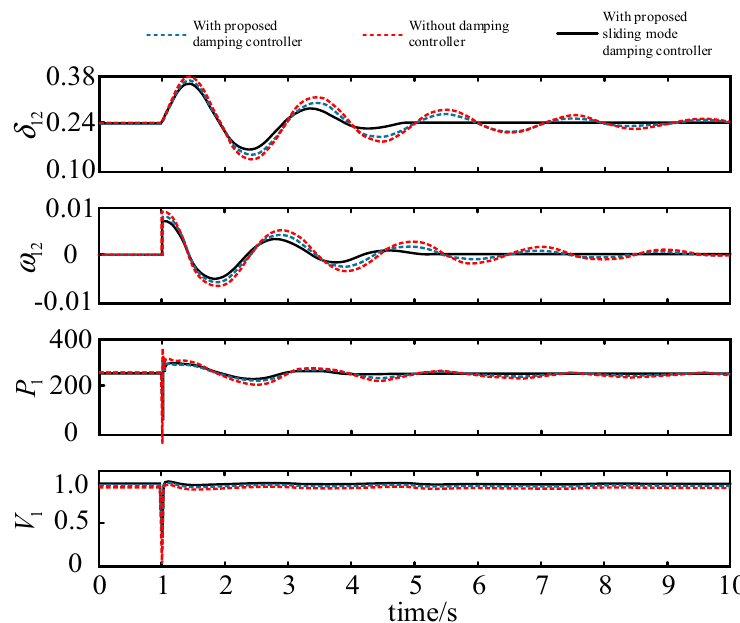
Figure 8. The dynamic reaction of line in case of a malfunction in midpoint.